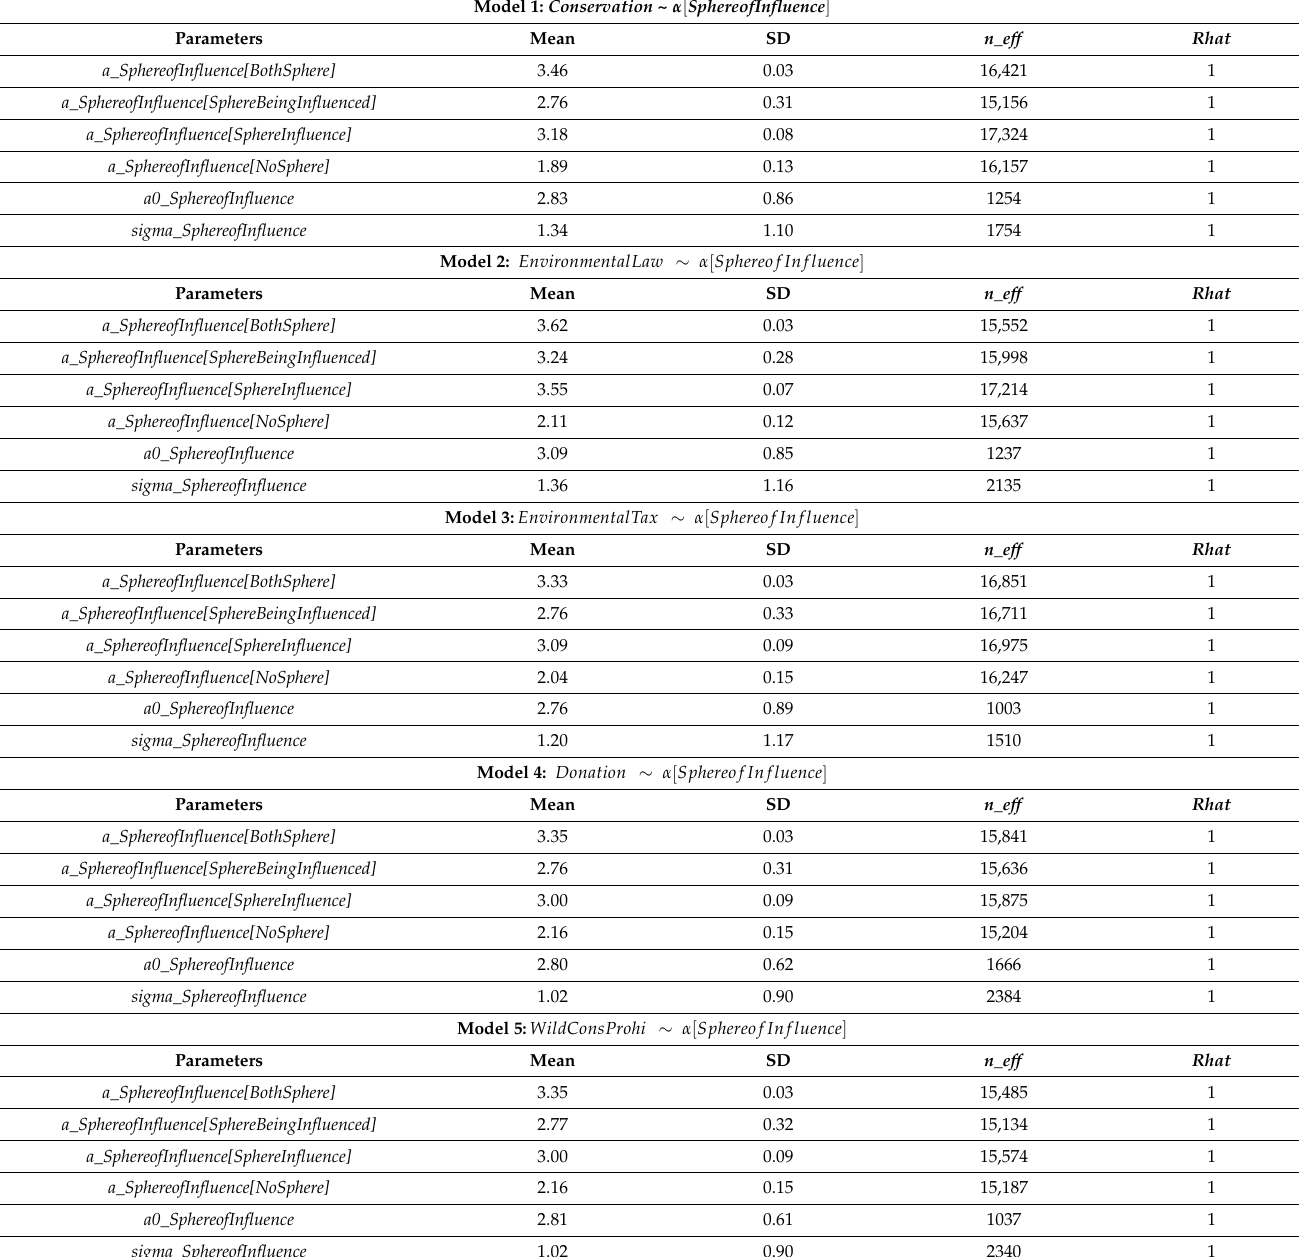
Table 4. Estimated posterior